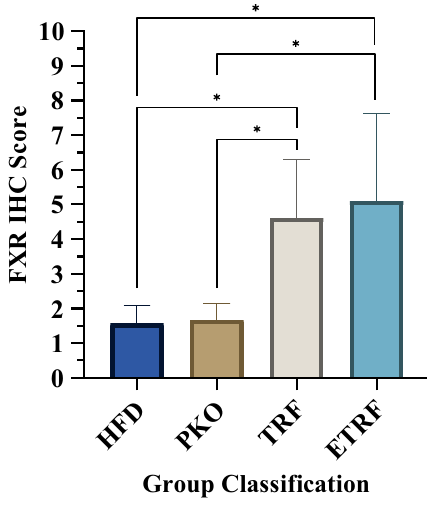
Figure 4. Farnesoid-X Receptor (fxr) immunohistochemistry (IHC) scoring based on IHC Scoring. Expression of fxr is significant with TRF when compared to HFD and PKO, respectively. Expression of fxr was also significant with ETRF when compared to HFD and PKO, respectively (* p < 0.05). Comparison between TRF and ETRF was not significant ( p > 0.05). Data is expressed as mean of scoring ± standard deviation (SD). (n =